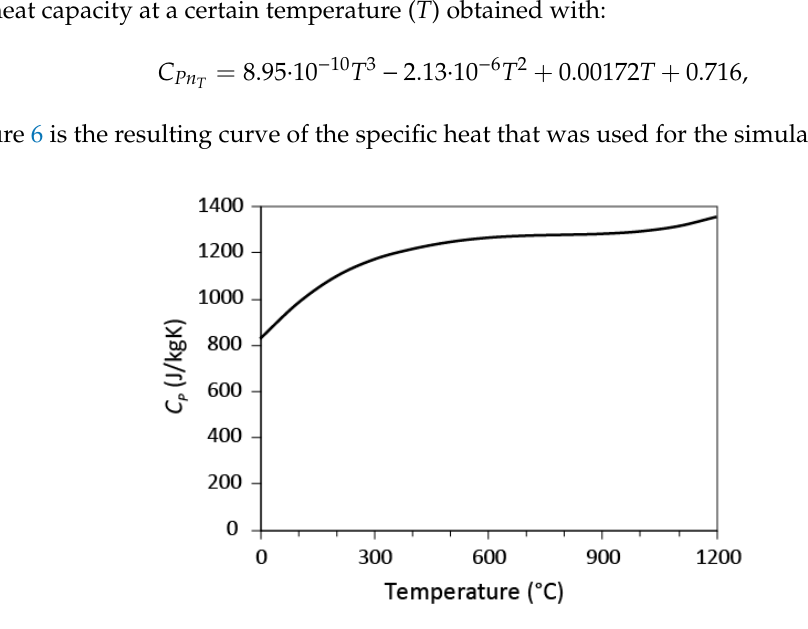
Figure 6. Specific heat of the growing medium at different temperatures.